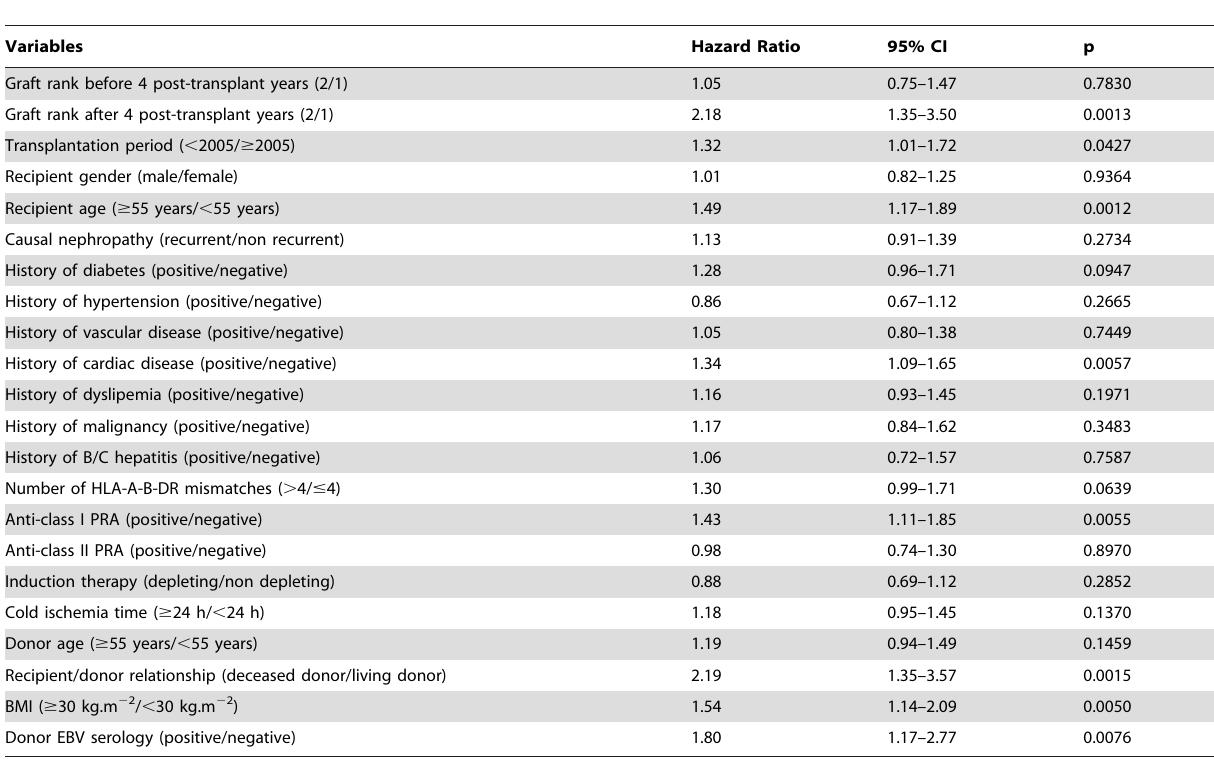
Table 2. Multivariate Cox model analysis of graft failure risk factors (N= 2772, as 257 first transplant recipients and 74 second transplant recipients presenting missing data for one of the covariates were